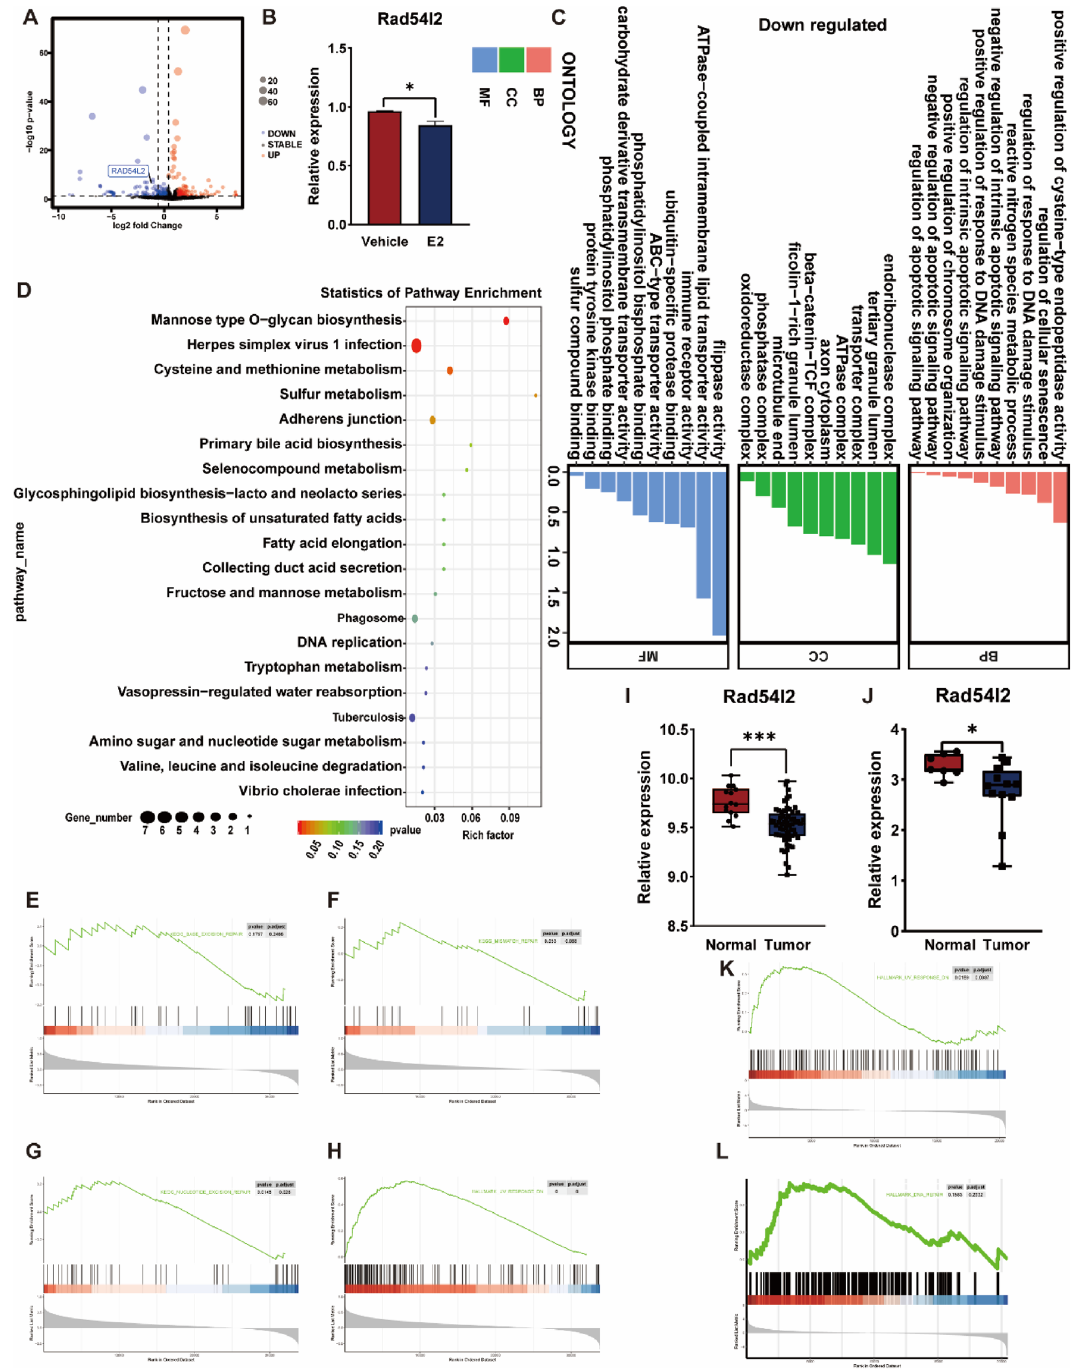
Figure 2. Rad54l2 was downregulated in HK-2 treated with estrogen and Xp11.2 tRCC. ( A ) RNA-sequencing found that Rad54l2 was downregulated after estrogen treatment. ( B ) qRT-PCR further confirmed this result. ( C , D ) GO and KEGG analysis enriched in DNA damage repair related clusters in RNA-sequencing. ( E – H ) GSEA enrichment analysis in DNA damage repair related clusters in RNA-sequencing. ( I , J ) Rad54l2 mRNA was downregulated in Xp11.2 tRCC. Data from (GSE167573) and (GSE150474) respectively. ( K , L ). GSEA analysis enriched in UV response down in Xp11.2 tRCC. Data from